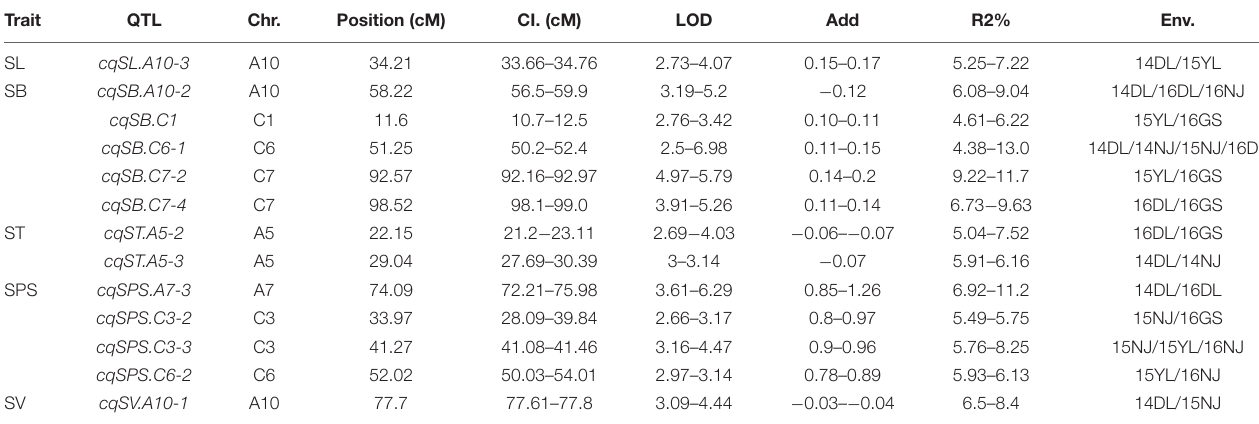
TABLE 3 | Consensus QTL obtained for the five silique-related traits detected in multiple environments. Trait QTL Chr. Position (cM) CI. (cM) LOD Add R2%